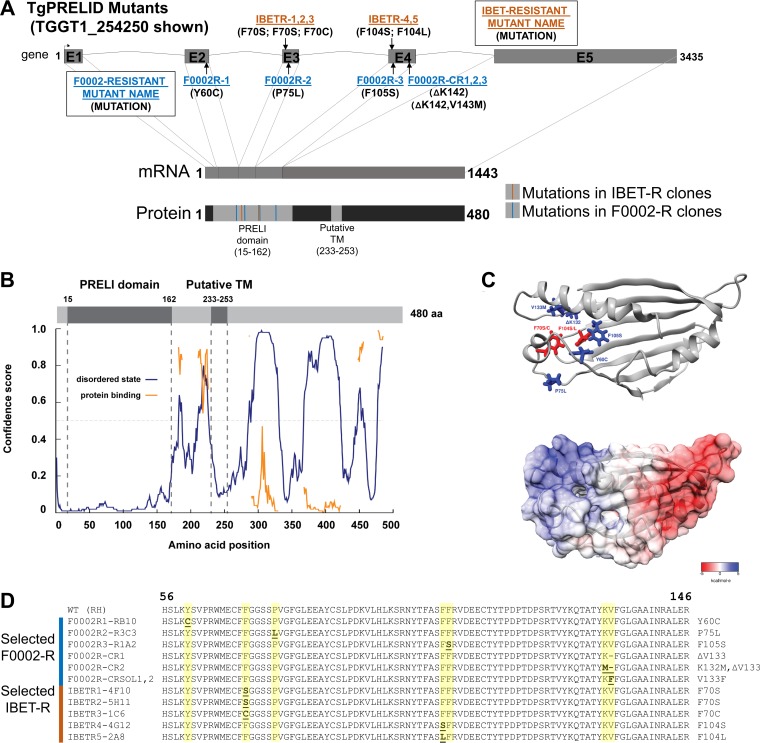
(A) Schematic of the TGGT1_254250/TgPRELID gene, mRNA, and predicted protein. Intron-exon boundaries were predicted in ToxoDB and confirmed by direct sequencing of TGGT1_254250 transcript. Protein domain searches were done using Pfam, identifying a PRELI domain in amino acid residues 15 to 162. A putative transmembrane domain was also predicted using the Psipred and TMPred servers (residues 233 to 253). (B) Disopred3 analysis of TgPRELID polypeptide indicates a high probability of order in the first 150 amino acids (aa) that corresponds to the PRELI domain. Extensive patches of disorder are predicted C terminal to the PRELI domain. Some of these are also predicted to be protein binding (orange trace). (C) I-TASSER-predicted structure of TgPRELID PRELI domain (C score = 1.18), with identified mutations highlighted (IBETR, red; F0002R, blue). The electrostatic surface potential was calculated using APBS and mapped to the TgPRELID surface, in a gradient from negatively charged residues (red) to positively charged residues (blue). (D) Location of all TgPRELID mutations identified in ENU and CRISPR screens for F0002- and I-BET151-resistant mutants. All mutations associated with resistance to either F0002 or I-BET151 were located within the putative PRELI domain. In addition to F0002R mutants 1, 2, and 3, the three classes of CRISPR/CAS9-mediated resistance mutations are shown (CR1 and CR2 and that found in clones CRSOL1 and CRSOL2). All CRISPR-driven mutations showed no evidence for incorporation of the homology repair template containing the F105S mutation but instead resulted in either the deletion or the mutation of valine 133.